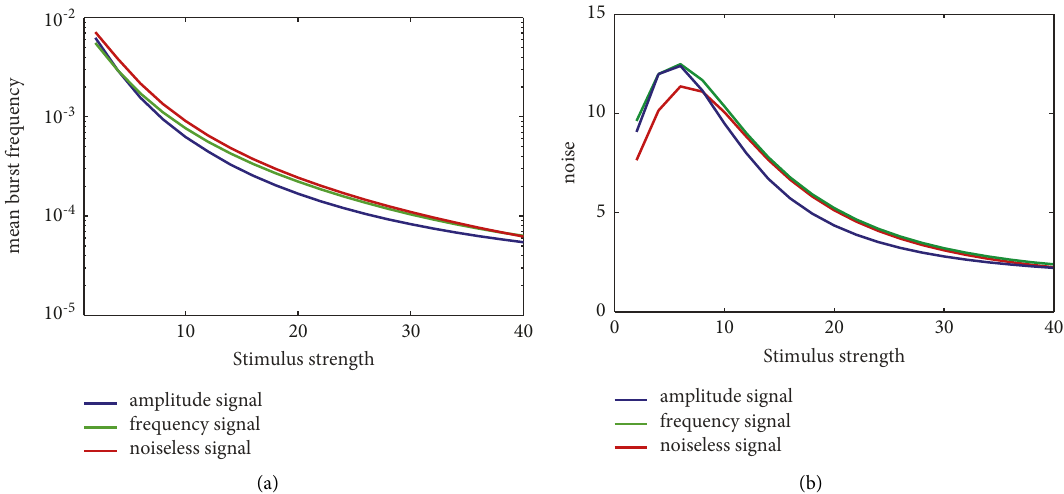
Figure 5: The mean burst frequency (a) and the noise (b) of downstream gene expression are under the FM modulation paradigm, and the mean burst size of downstream gene expression is constant ( 〈 burstsize 〉 � 500) when the extracellular stimulus strengthens and represses downstream gene expression. The red line represents the upstream stimulus signal as noiseless, and the green line represents the upstream stimulus signal as random with the burst frequency ( α ) changing and the burst size ( β ) being equal to 2, while the blue line represents the upstream stimulus signal as also random with the burst frequency ( α ) being equal to 2 and the burst size ( β ) changing. The other parameters are the same as in Figure